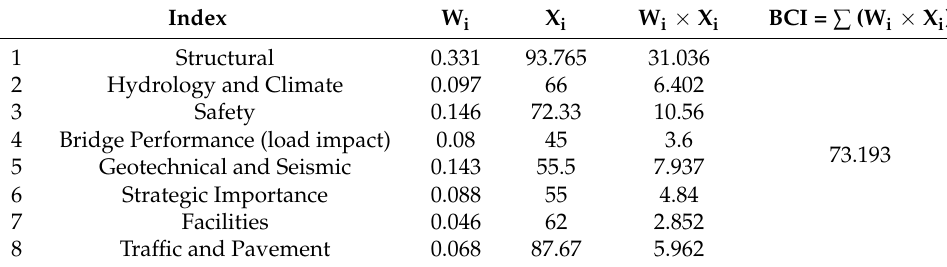
Figure 15. The pavement condition of bridge No. 3. Table 20. BCI calculation of the bridge No.